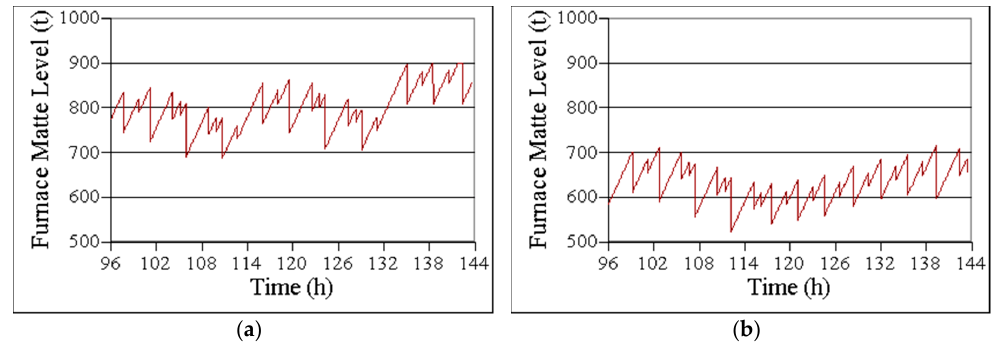
Figure 9. Matte levels of the smelting furnace with data from Tables 1–3, in which ( a ) exceeding 800 t triggers two long cycles and ( b ) exceeding 700 triggers three long cycles. The second case is safely below the maximum holding capacity of 900 t.